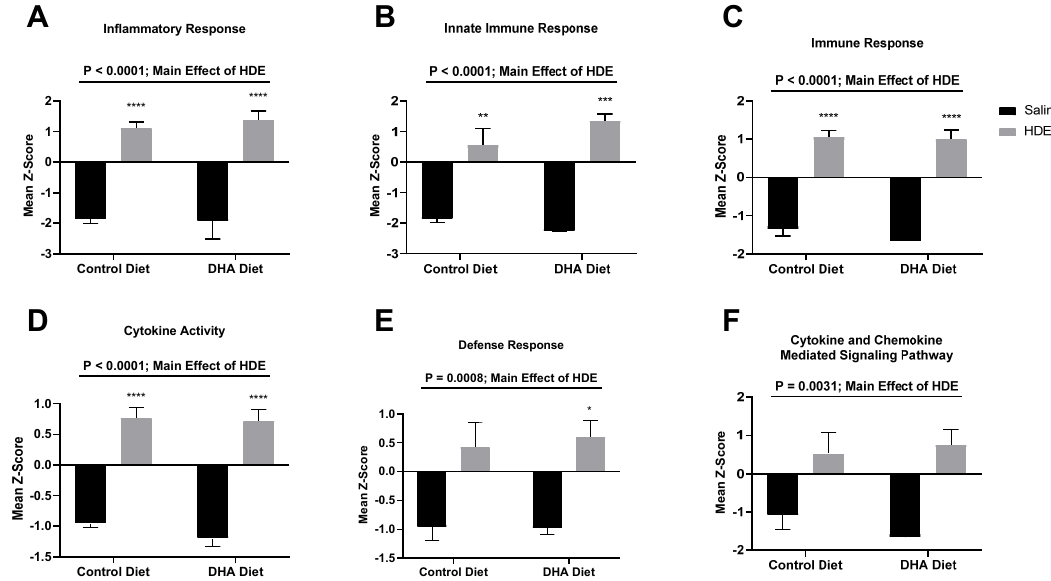
Figure 7. Expression changes in significantly altered pathways among all 20 DHA- vs. control-diet-fed mice. nSolver Advanced Analysis was performed to assess significant changes among pathway z-scores for various immunological pathways including inflammatory response ( A ); innate immune response ( B ); immune response ( C ); cytokine activity ( D ); defense response ( E ); and cytokine and chemokine-mediated signaling pathway ( F ). A major e ff ect for HDE vs. saline exposure is indicated by the top significance bars and p -values. The * symbol above the HDE bars represents p < 0.05 versus all saline-treated conditions; ** p < 0.01; *** p < 0.001; **** p <